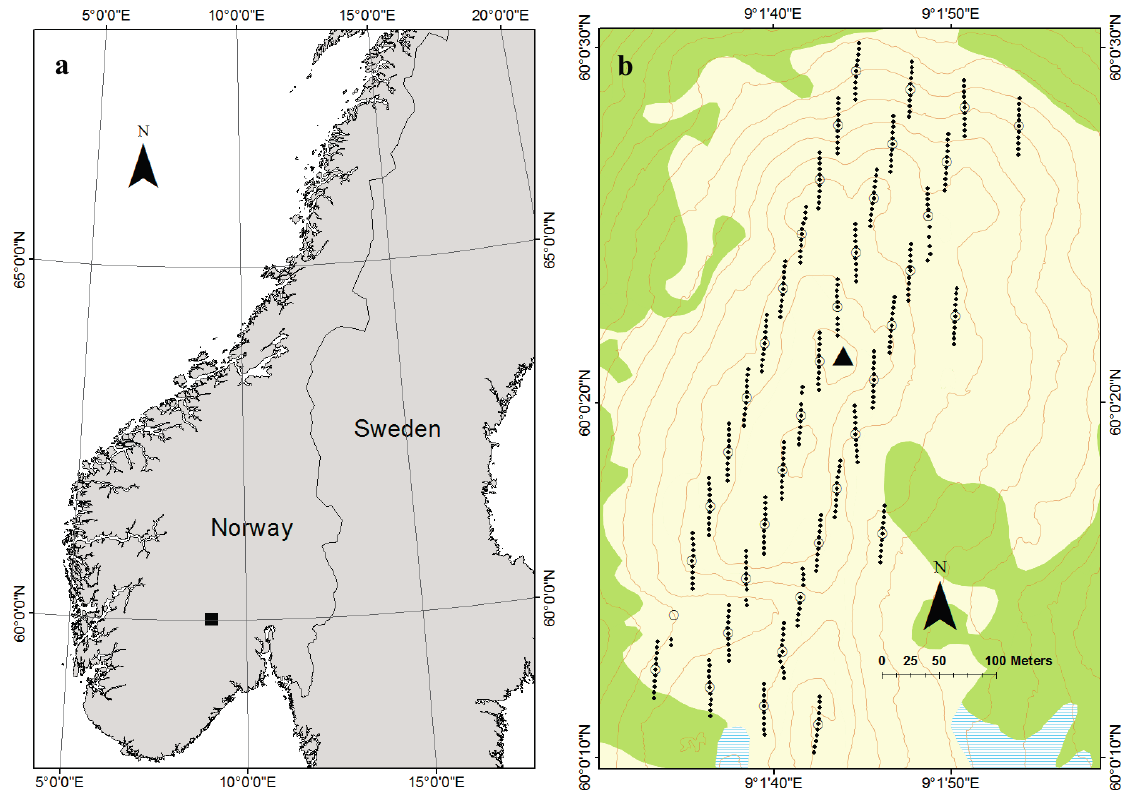
Figure 1. ( a ) Location of the study area in southern Norway (black square); ( b ) Design of the trial. The predefined sample points are marked as circles ( n = 40) and those that were identified in field ( n = 39) and terrain control points ( n = 387) are shown as black dots. The green area is defined as forest according to the official N50 topographic map